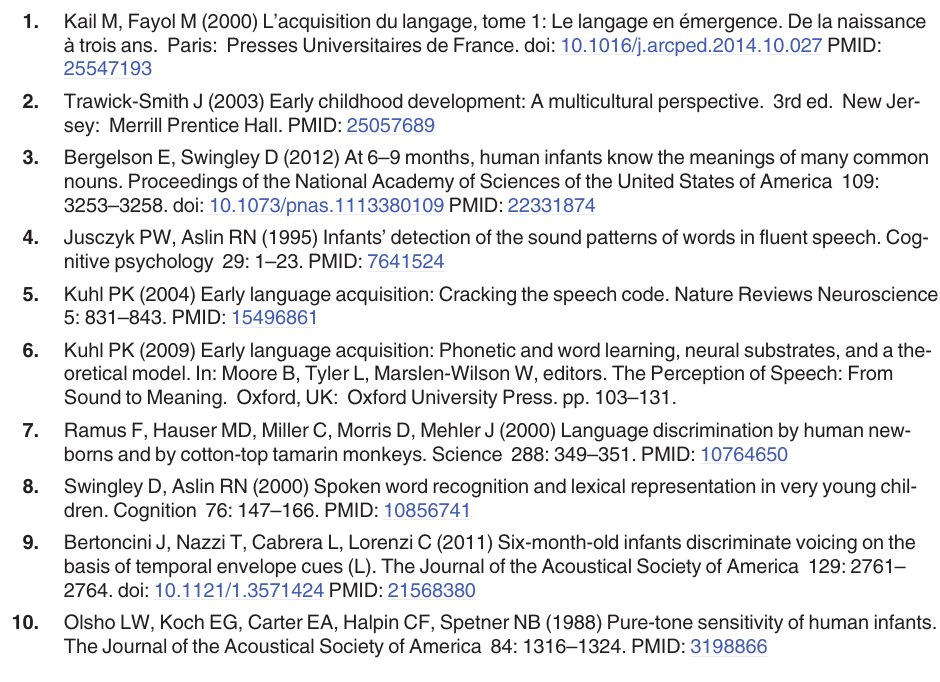
S1 Table. Individual data of FST. Results for 6, 7 and 8 years old participants. Each column represents the classification performed by an individual subject, and in each line, we are pro- viding the category number in which the individual sounds have been pooled together. In con- sequence, for each individual, the highest number corresponds to the maximum number of classes performed by the subject. S2 Table. Individual data of FST. Results for 9, 12 – 13 years old participants and adults. Same convention as in S1